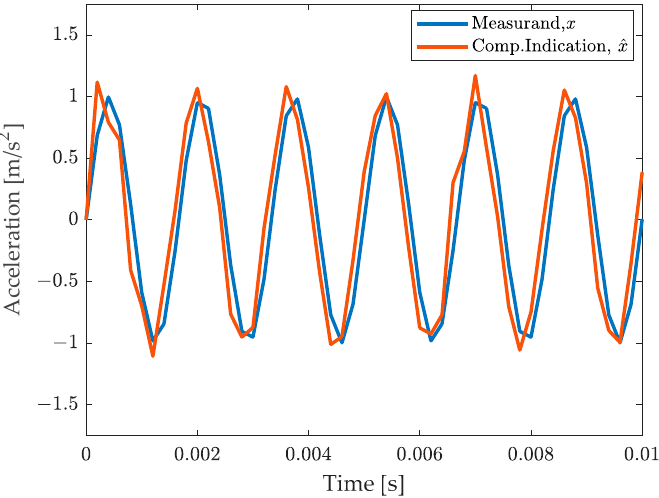
Figure 4. Comparison of the measurand with the final, compensated measurement result.